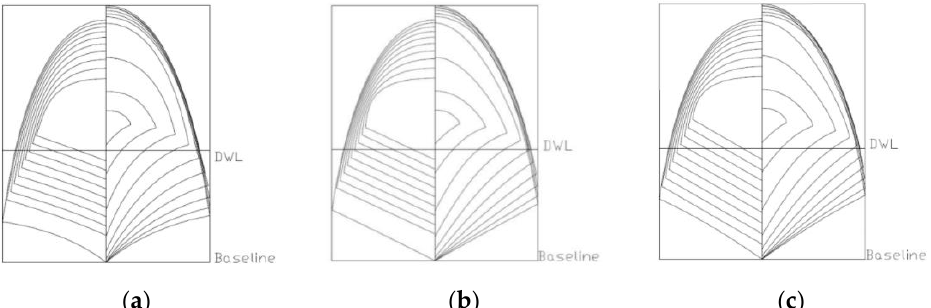
Figure 4. Initial float with different deadrise angle: ( a ) Deadrise angle at 20 degrees; ( b ) Deadrise angle at 25 degrees; and ( c ) Deadrise angle at 30 degrees.